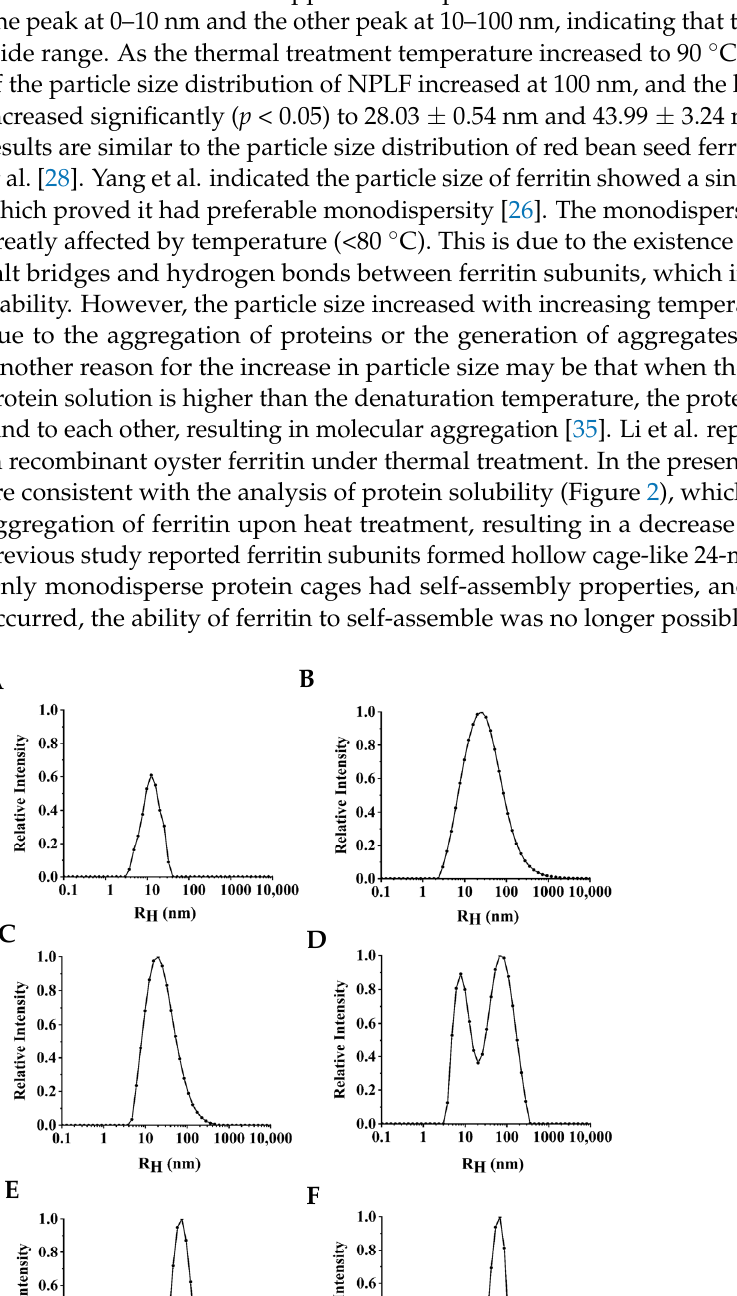
Figure 4. Effects of thermal treatment at different temperatures (untreated, 60, 70, 80, 90, and 100 °C) for 10 min on the hydraulic radius of ferritin. Values with different letters are significantly dif- ferent ( p < 0.05). 3.4. Secondary Structure Changes of NPLF under Thermal Treatment Ferritin as a new type of iron supplement, and its bioactive function depends on its unique cage structure and chemical properties. Therefore, we explored the effect of